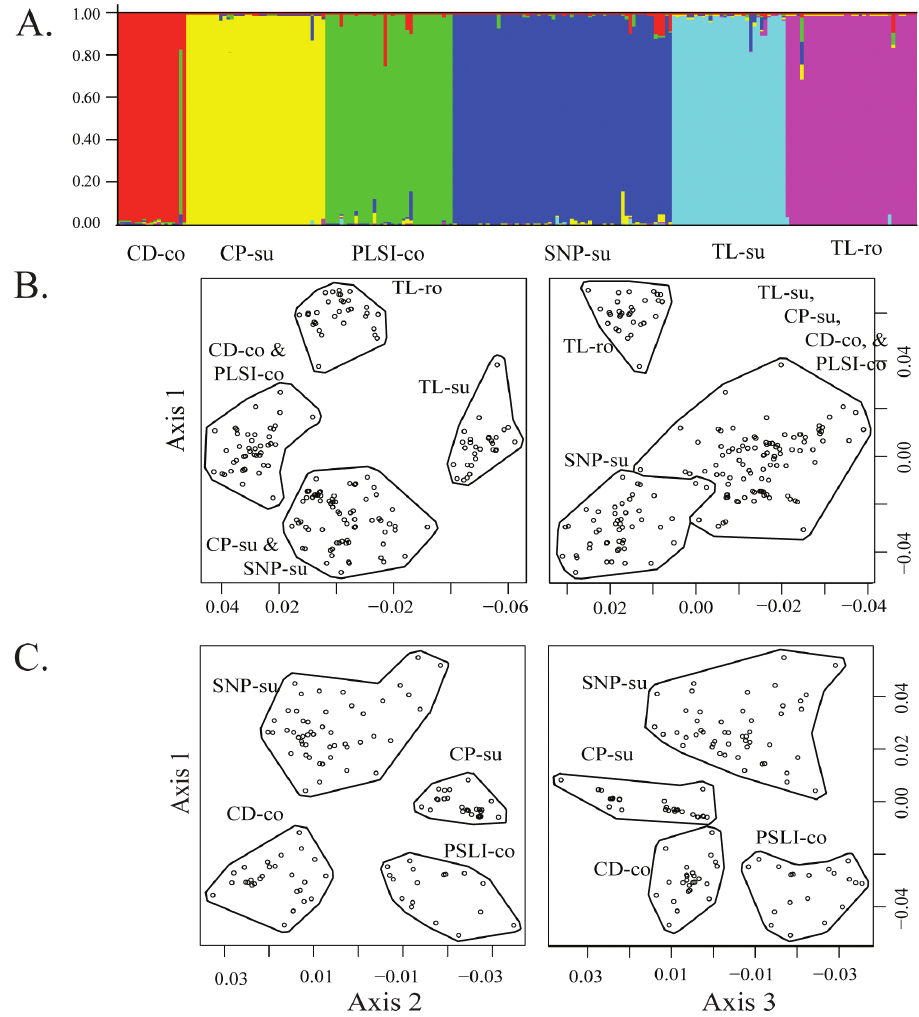
Figure 2. Results from Analysis 2 (which excluded TL-co). A STRUCTURE bar plot with K = 6 B MDS mi- crosatellite plot of first three axes at K = 6 as found with the gap statistic C MDS plot with TL-su and TL-ro, the most divergent clusters, excluded to demonstrate coherence of the remaining four clusters (gap statistic K =